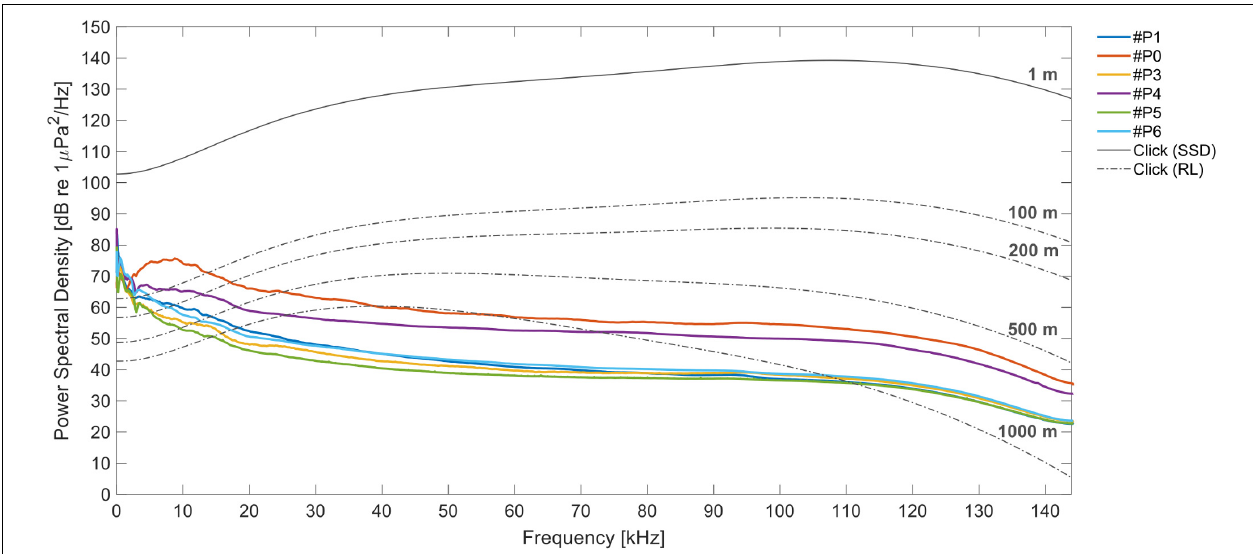
FIGURE 4 | Detection range. The average calculated over all power spectral densities (PSDs, dB re 1 µ Pa 2 /Hz) measured for the files acquired by the six platforms (different colors). The gray curve represents the PSD of an IPHD click as source spectral density (SSD, dB re 1 µ Pa/ levels (RL) model of the click, respectively, at 100, 200, 500, and 1000 m. The variation of the signal during propagation is shown in relation to the ambient noise recorded at the PAM